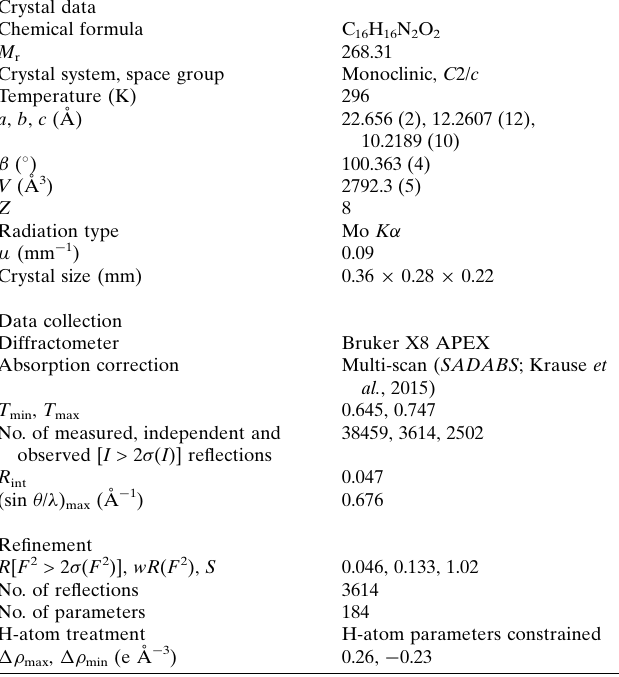
Table 2 Experimental